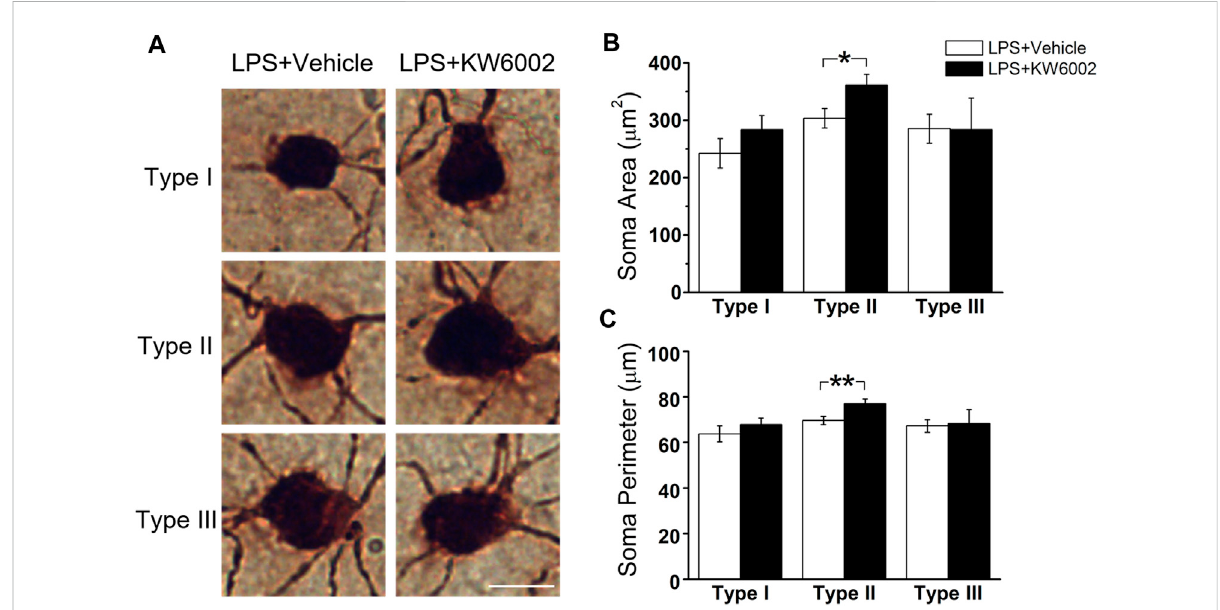
FIGURE 6 KW6002 enlarged the soma of Type II RGCs after neonatal LPS exposure. (A) Representative pictures of somata in each RGC type examined from vehicle -treated and KW6002-treated group after neonatal LPS exposure. Scale bar, 20 μ m. (B , C) Comparative analysis of soma area (B) and perimeter (C) of different RGC types between vehicle-treated and KW6002-treated mice after neonatal LPS exposure. Data represent mean ± SEM. * p < 0.05; ** p <